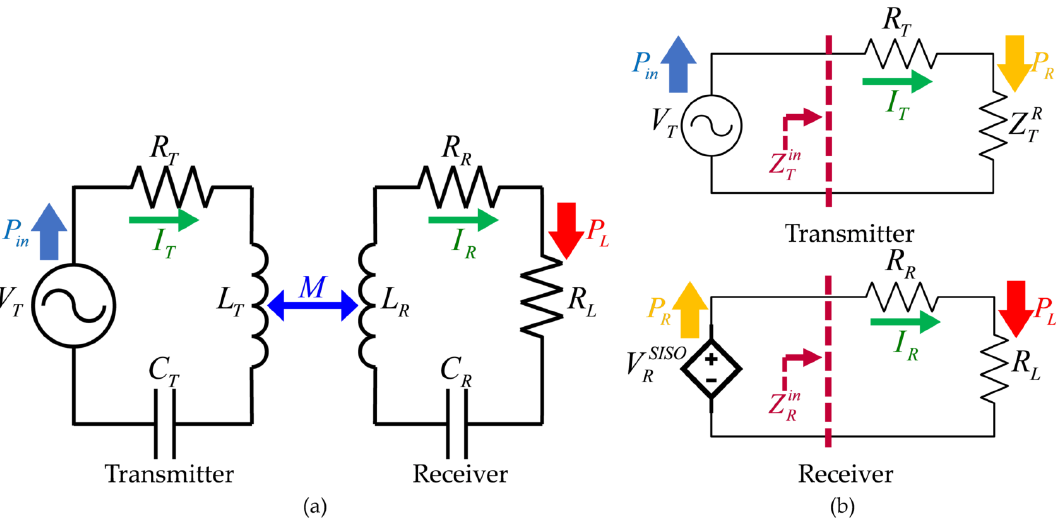
Figure 3. Circuit modeling of SISO-WPT: ( a ) simplified circuit and ( b ) equivalent circuit at magnetic